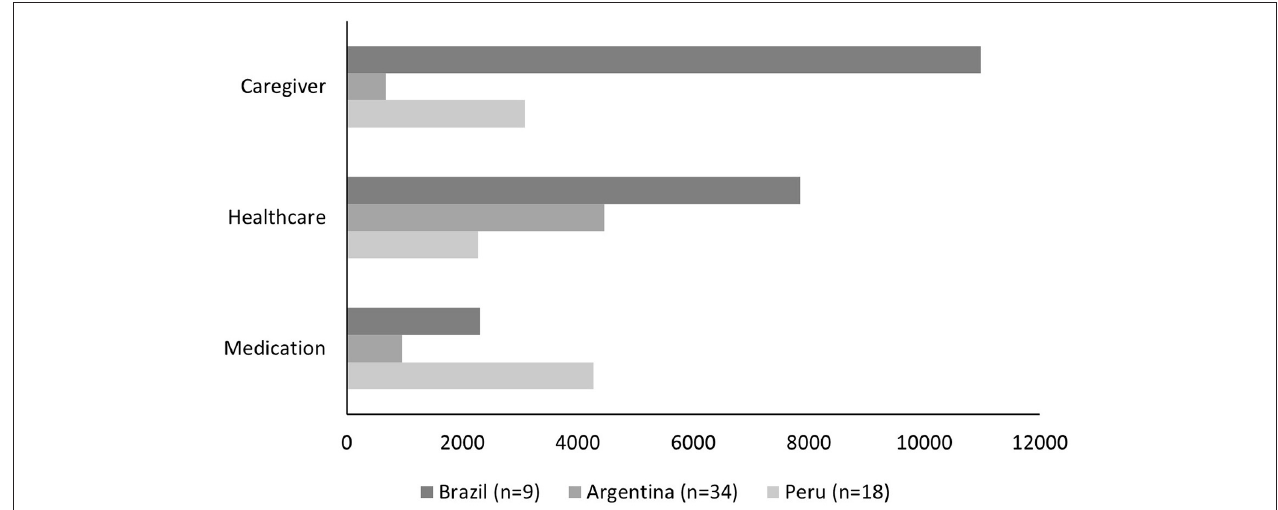
FIGURE 1 | Frontotemporal dementia annual direct cost components in US Dollars for three Latin-American